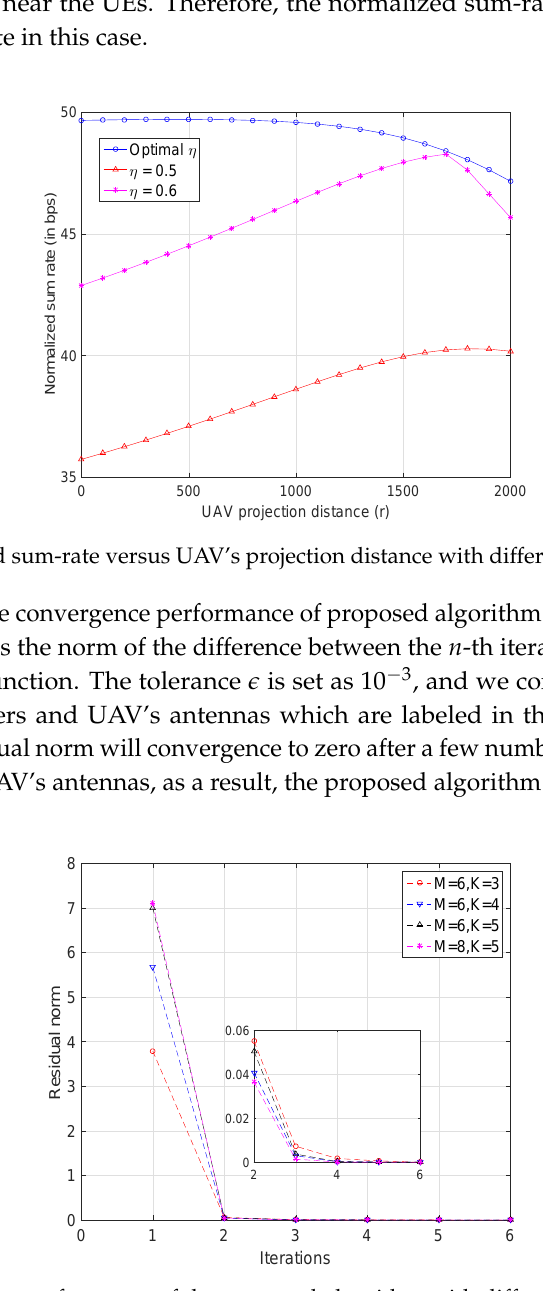
Figure 8. Convergence performance of the proposed algorithm with different number of users and UAV’s